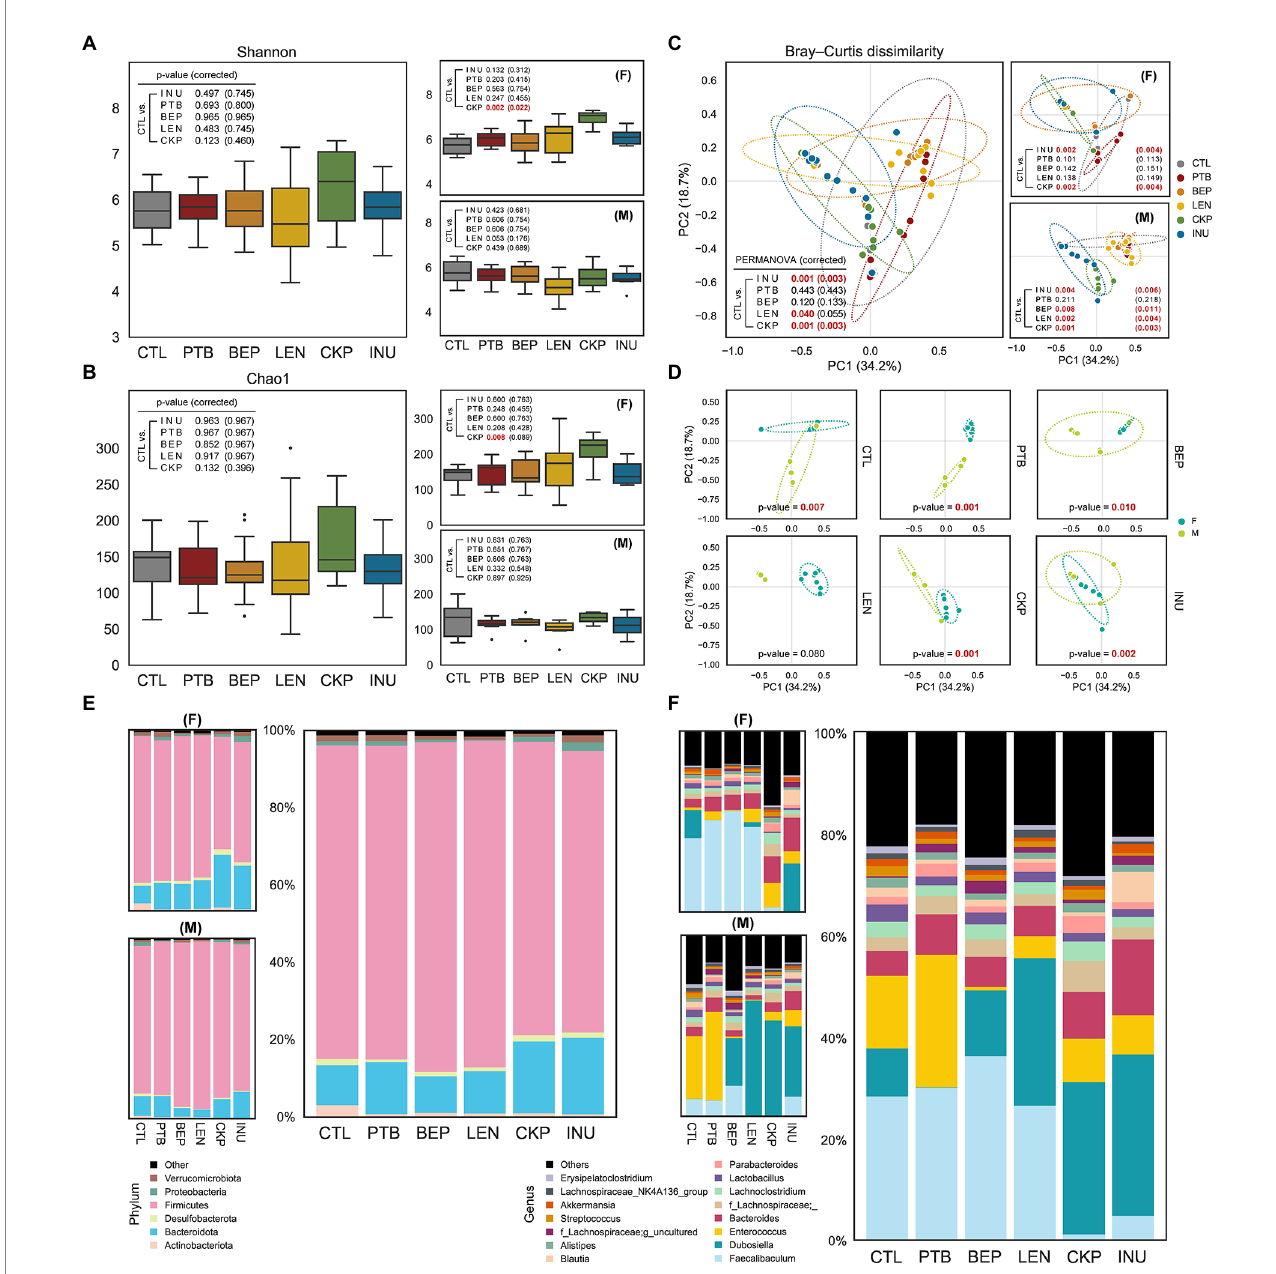
FIGURE 2 Effect of resistant starches from dietary pulses on gut microbiome diversity and taxonomic hierarchies. Alpha-diversity of microbiome of each group determined using (A) Shannon index and (B) Chao1 index. (C) PCoA analysis representing β -diversity of microbiome of each group combined or male and female groups. (D) Sex-specific differences in microbiome composition for each group; covariance ellipses are displayed and bounds (dotted lines) of each group with two standard deviations (2 σ ) in each direction from the group mean. Relative abundance of gut microbiome in male and female mice or all combined at (E) phylum level and (F) genus level. PTB, Pinto beans; BEP, black-eyed peas; LEN, Lentils; CKP, chickpeas; INU, inulin; CTL, control high-fat diet group. * p <